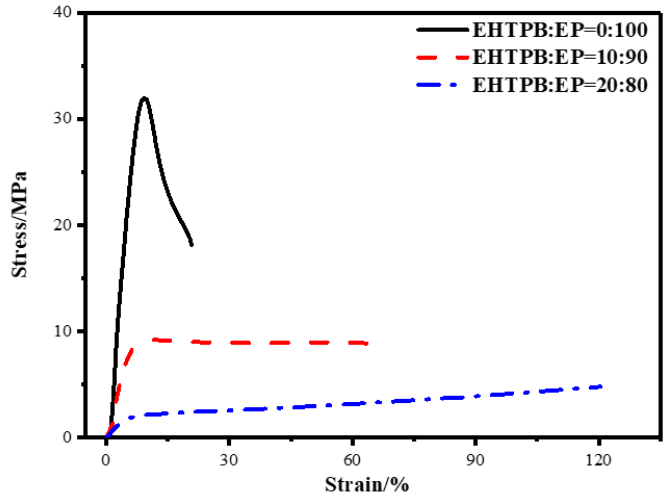
Figure 5. Stress–strain curves of the modified epoxy resin with different w(EHTPB)/w(EP)